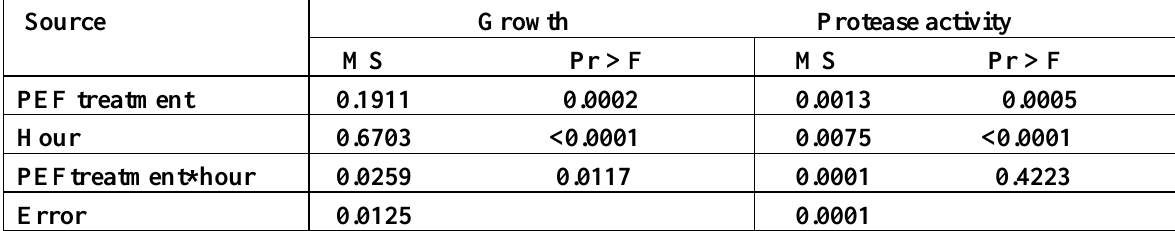
Table 1: Mean square (MS) and Pr>F of PEF treatment, hour, and their interaction for growth and protease activity of Streptococcus thermophilus .